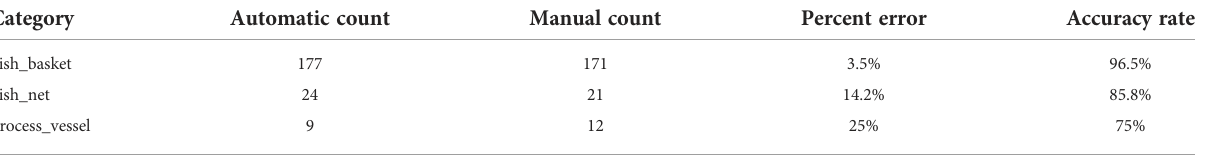
TABLE 3 Statistical results of